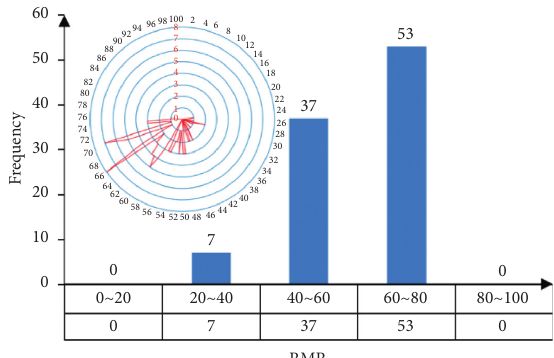
Figure 9: Rock mass RMR distribution statistics at the sampling